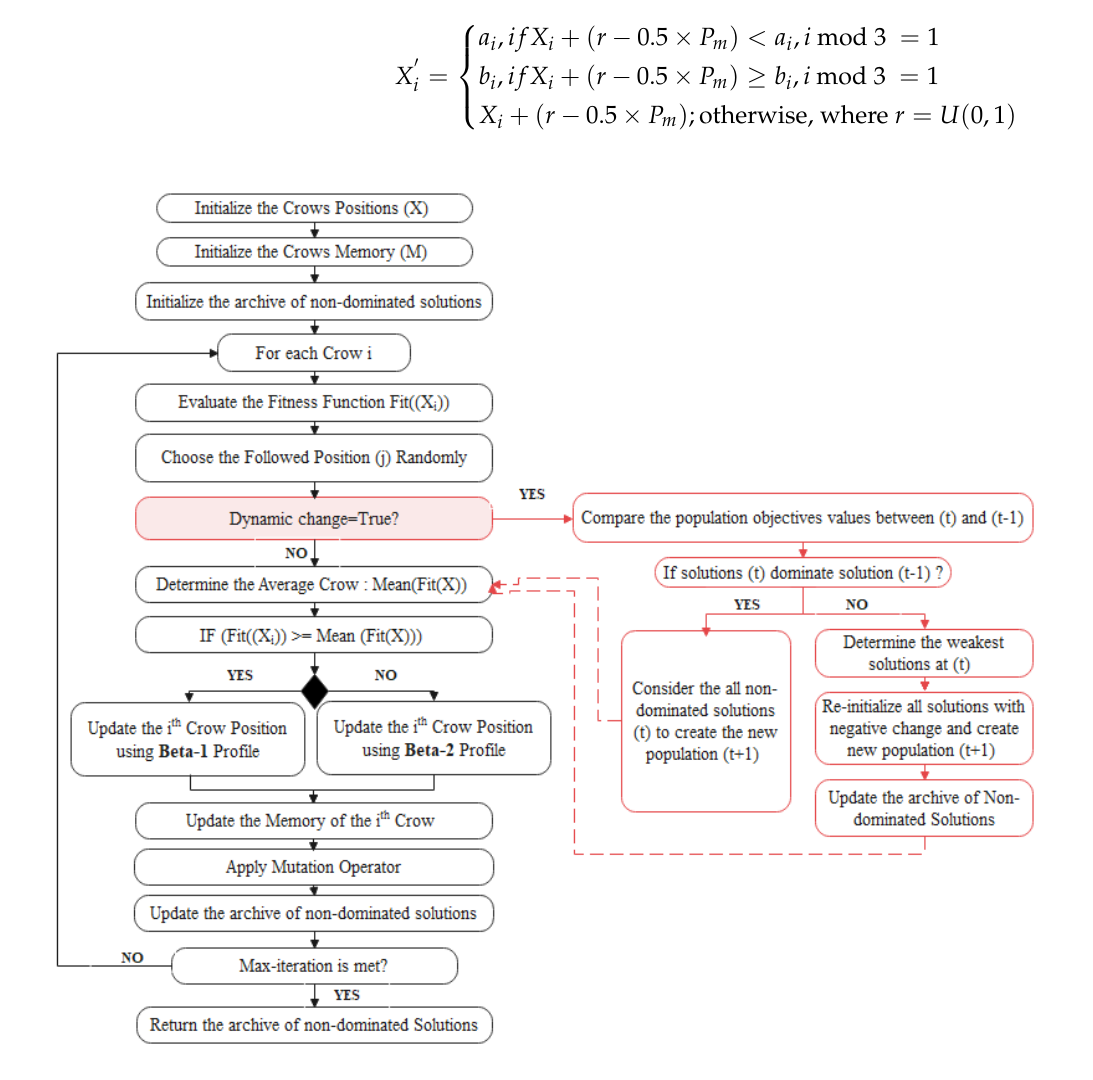
Figure 2. A modified flowchart of the proposed Distributed Bi-behaviours Crow Search Algorithm (DB-CSA-II) with Dynamic Optimization Process.